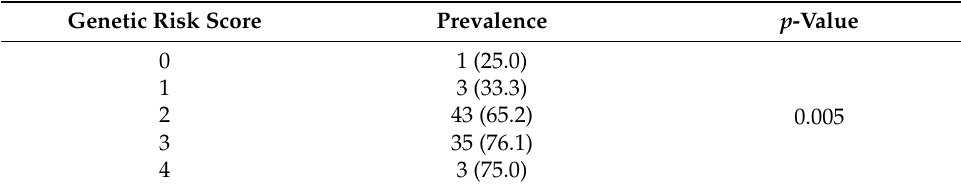
Table 5. PAD prevalence according to the genetic risk